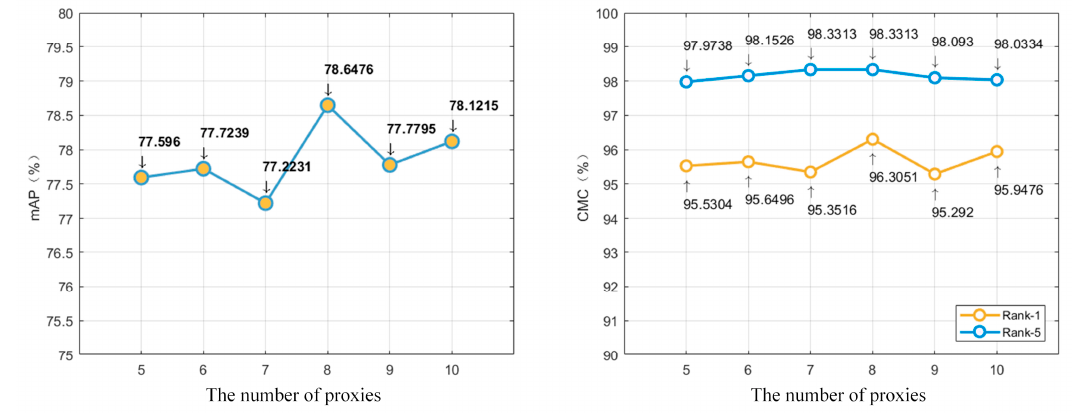
Figure 6. The comparison of di ff erent number of proxies on VeRi-776 dataset. The chart on the left shows the score of mAP, and the chart on the right corresponds to the scores of Rank-1 and Rank-5.